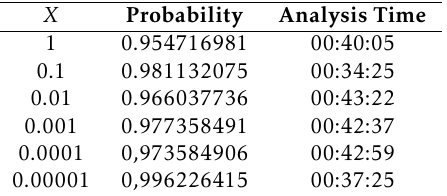
Table 2. Probability that fire area is smaller than X percent of the total area at least 90% of the